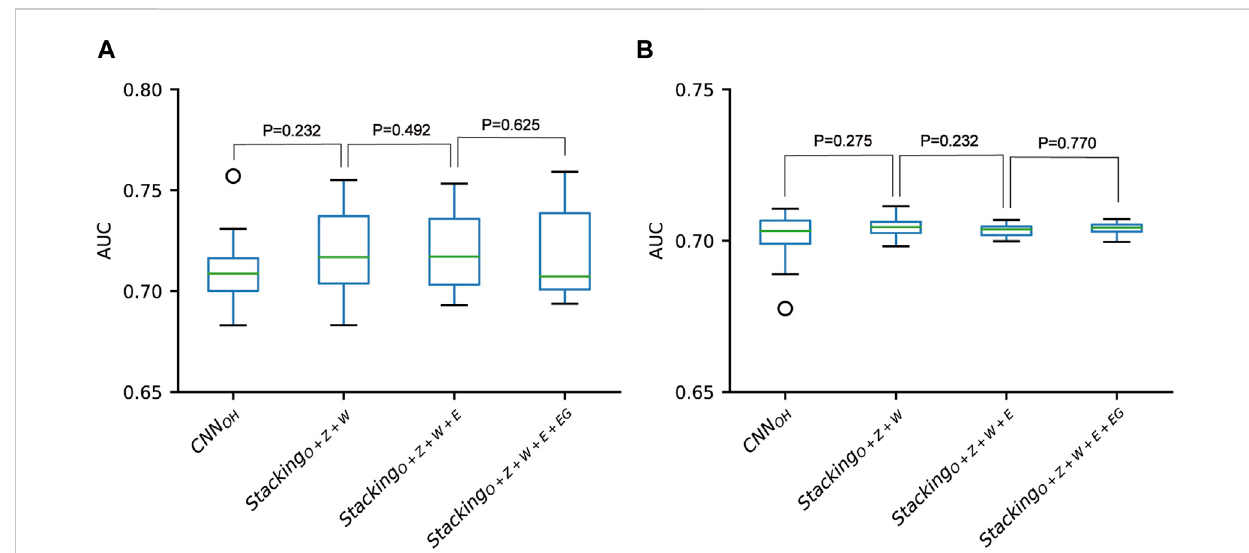
FIGURE 9 PerformancecomparisonbetweenCNN-basedclassi fi ersandthestacking-basedensembleclassi fi ersforthepSADPr-SADPrdatasetintheten-fold cross-validation (A) and independent test (B) . p values were calculated using the two-sided Mann – Whitney U